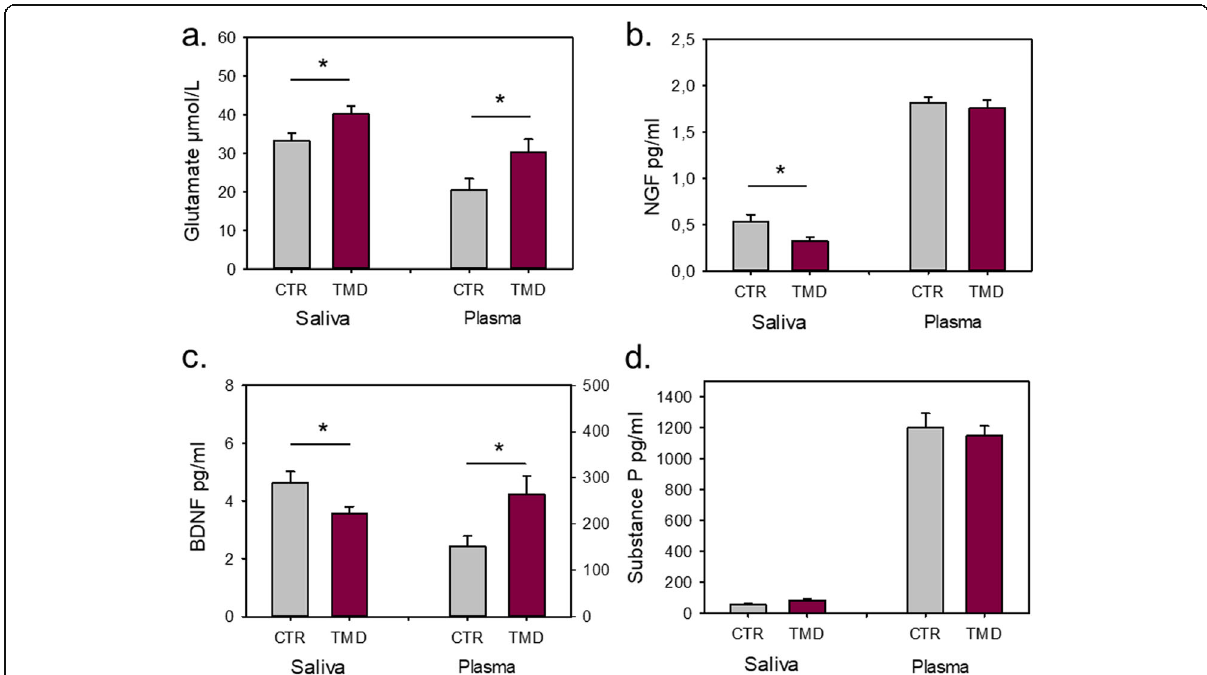
Fig. 1 a - d . Salivary and plasma biomarkers. Salivary and plasma levels of glutamate, nerve growth factor ( β NGF), brain derived neurotrophic factor (BDNF), and substance P (SP) in 39 patients diagnosed with temporomandibular myalgia according to the diagnostic criteria for temporomandibular disorders (TMD) and 39 healthy pain-free controls